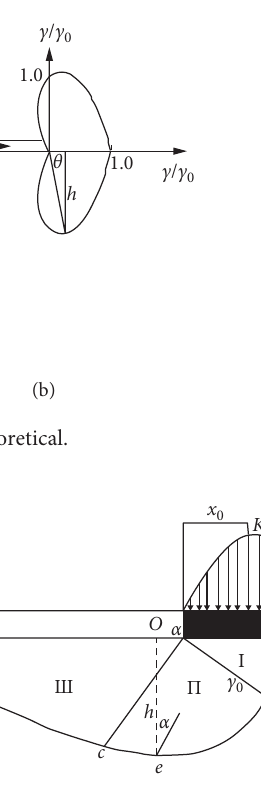
Figure 5: Theoretical mechanical model of slip line field.